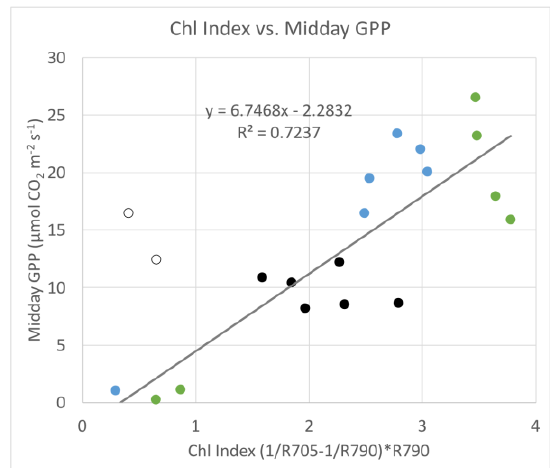
Figure 6 . C i using the 705 nm red edge band from DESIS compared with midday GPP from flux towers. Point colors are described in Fig. 3